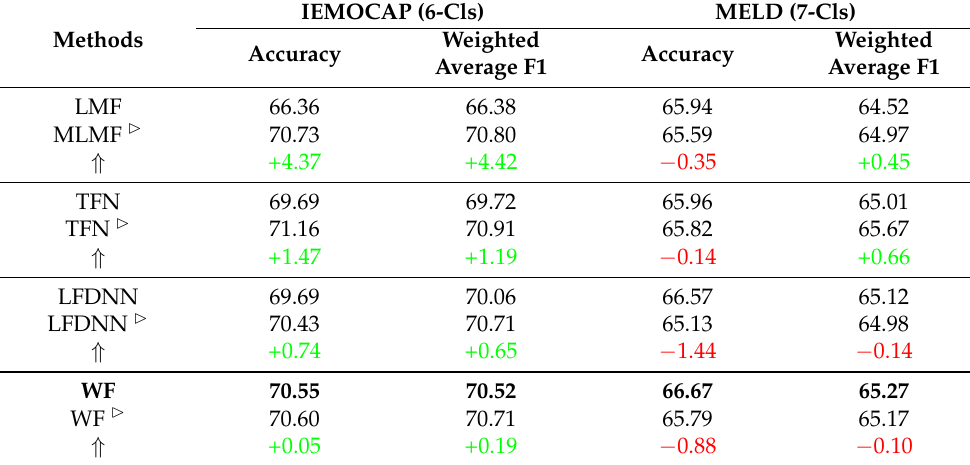
Table 2. Comparison of single-task and multi-task results with different fusion strategies on MELD and IEMOCAP datasets. The models with (cid:66) are multi-task models. The symbol ⇑ means improve- ments or reductions in multi-task compared to single-task models in the current evaluation metric. green mean positive upper direction arrow, a gain or an improvements in performance for multi- task models compared to single-task models. red means negative direction arrow, a decrease in performance for multi-task models compared to single-task models